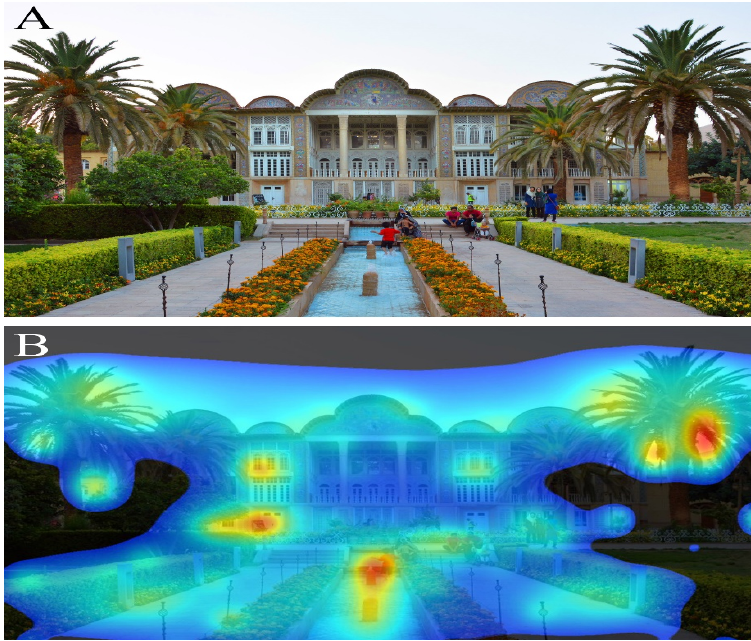
Figure 13. ( A ) The Qavam House from the 1870s, situated in the Eram Gardens in Shiraz, Iran. ( B ) Eye-tracking simulation heatmap.